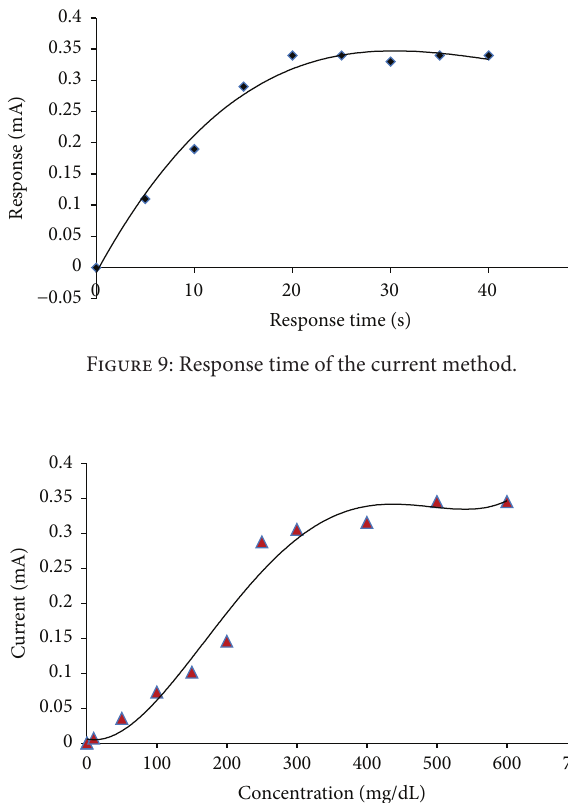
Figure 10: Effect of cholesteryl acetate concentration on the present